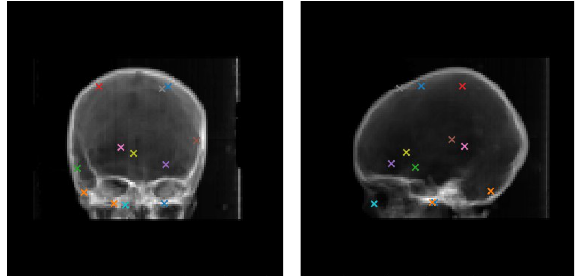
Figure 5. A example of 12 landmarks in head CT image.